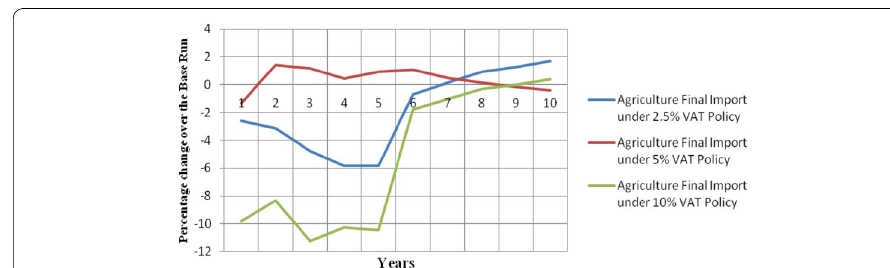
Fig. 34 Changes in agricultural final imports under varying VAT